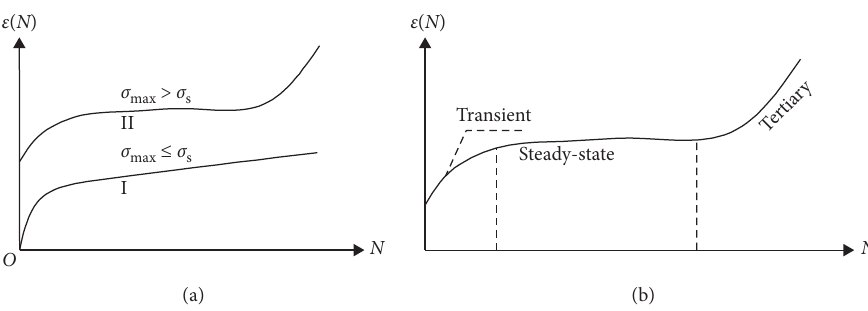
Figure 1: Typical creep characteristics of the rock under cyclic loading [43]. (a) Creep curves of the rock under cyclic loading. (b) Division of creep